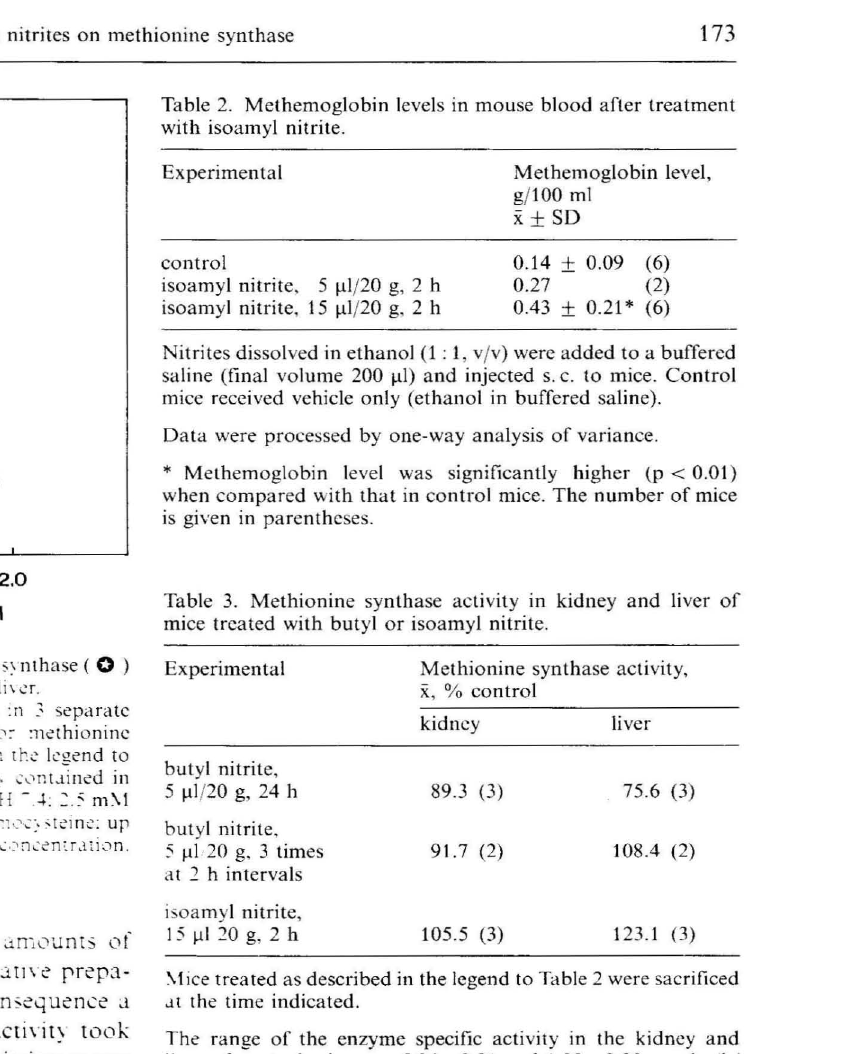
Table 1. Effect of isoamyl nitrite on activity of methionine synthase from mouse kidney in the presence or absence of exogenous vitamin B\2.